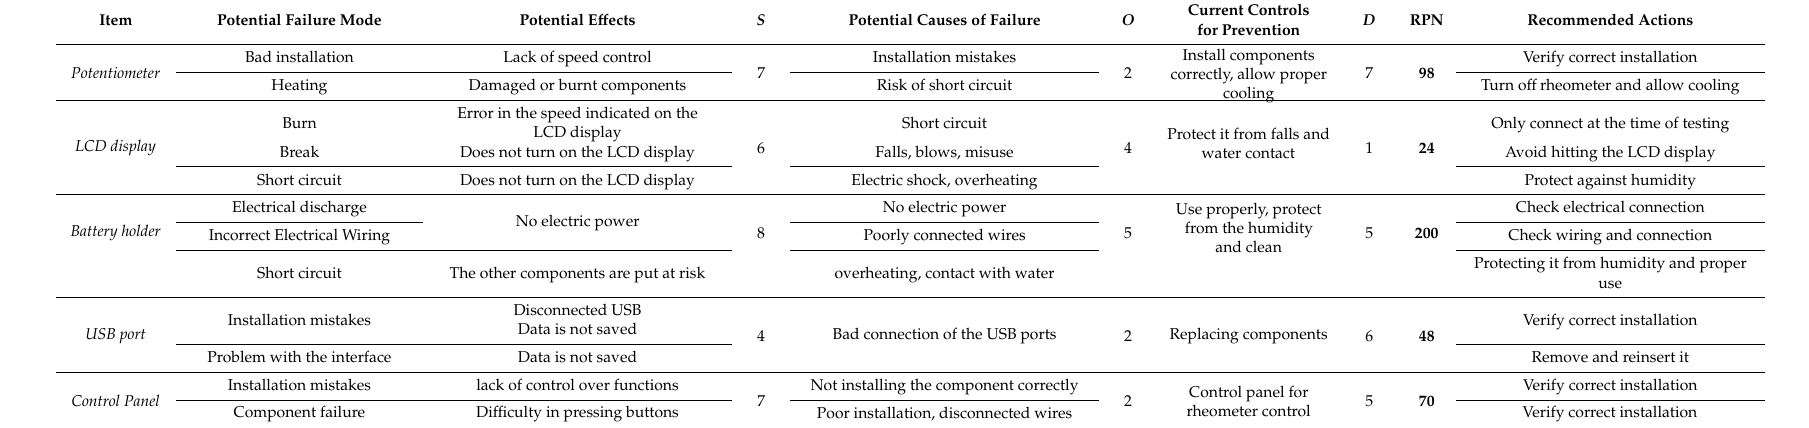
Table 6. FMEA—low-cost rheometer: electrical and electronic